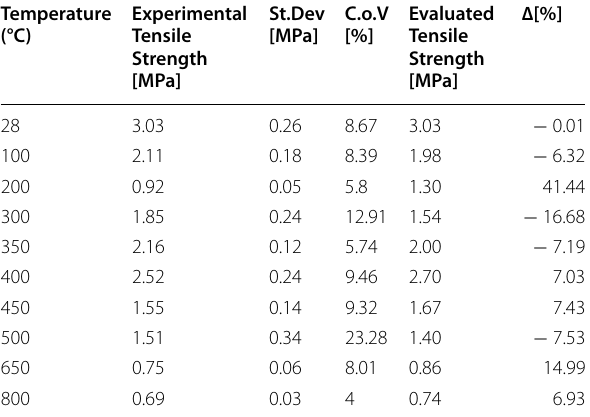
Table 5 Experimental results and evaluated tensile